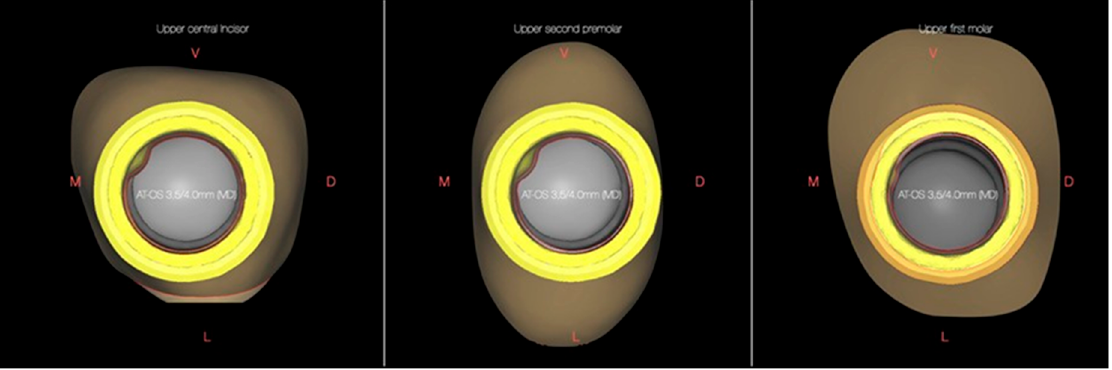
Figure 6. Three-dimensional model of standardized abutments virtually sectioned horizontally at 3 mm above the implant platform. Occlusal view of critical areas at risk of fracture. The remaining thickness of the material was measured in the medial, distal, buccal, and palatal areas (Table 2). Table 2. Measurements of remaining thickness of the ceramic walls around the implant abutment on the scheme and on the 3D model slices. Critical areas possessing a thickness of less than 0.5 mm are considered to pose a high risk of fracture.